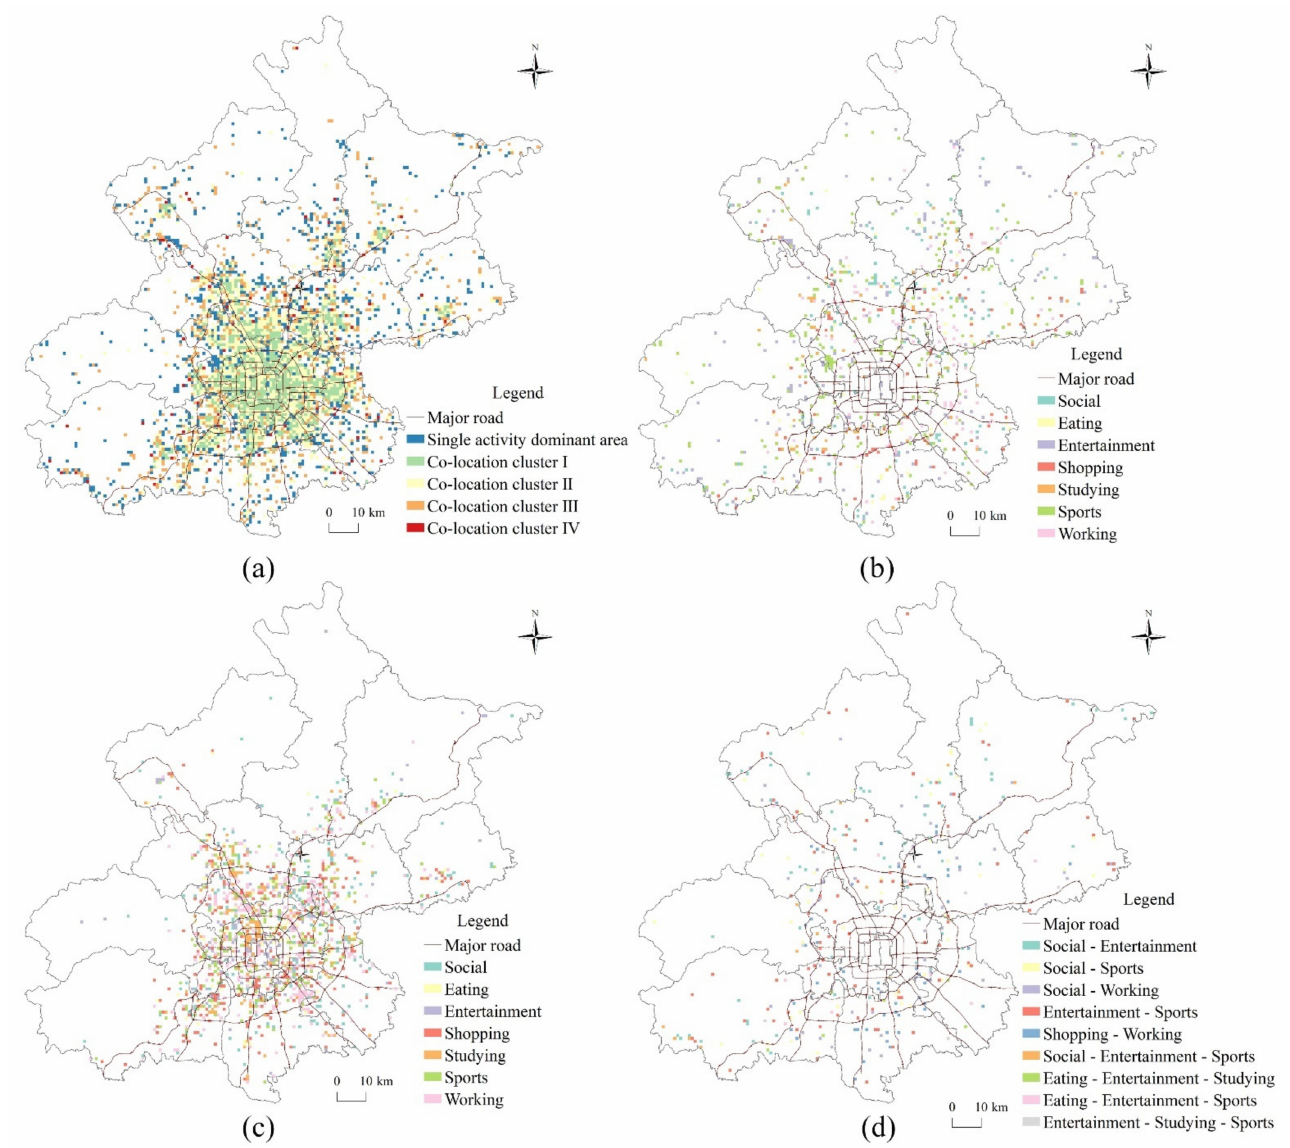
Figure 7. The spatial distributions of residential activity clusters and activity combination patterns. ( a ) Division of residential activity clusters; ( b ) single-activity-dominant areas; ( c ) co-location cluster II; ( d ) co-location clusters III and